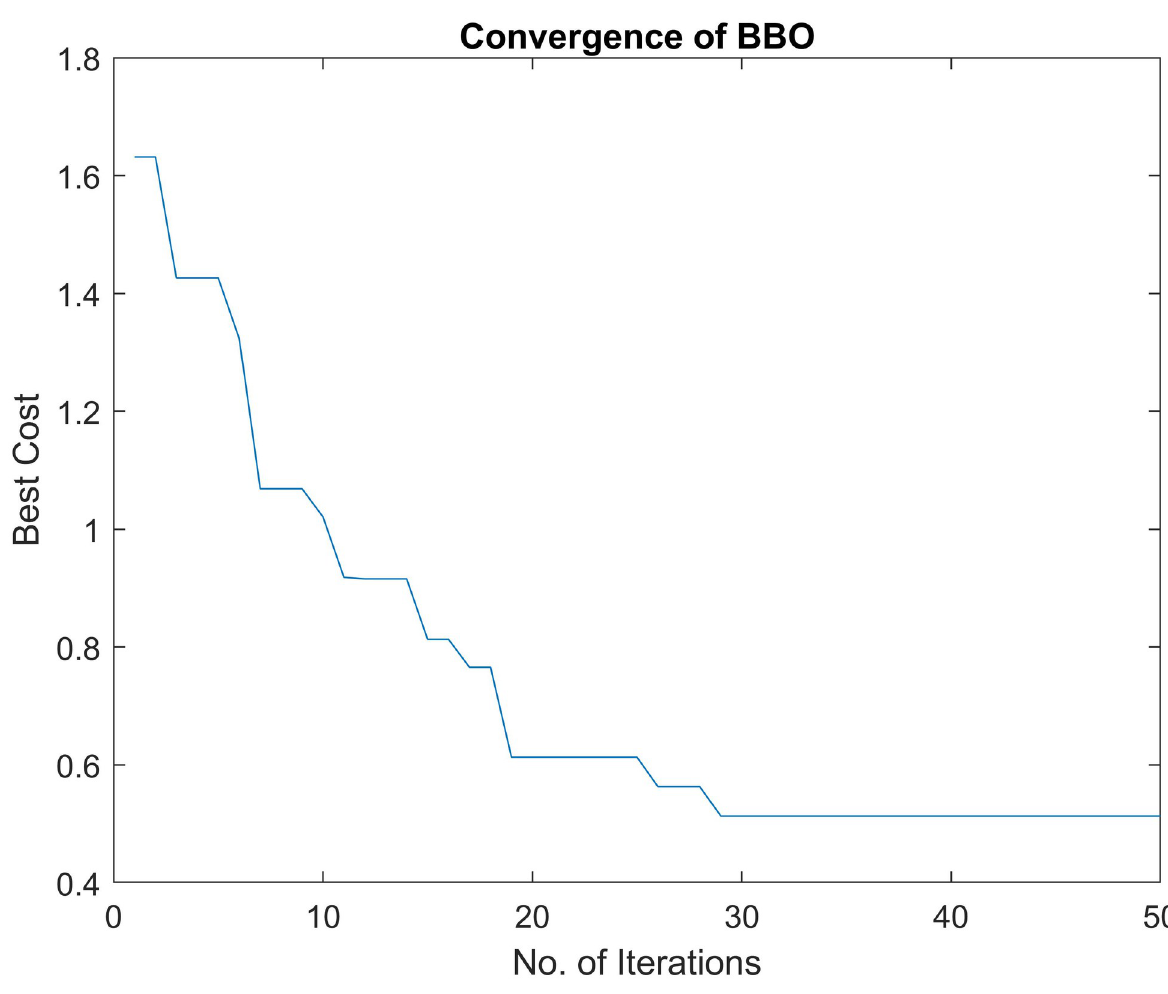
Fig 4. Convergence of